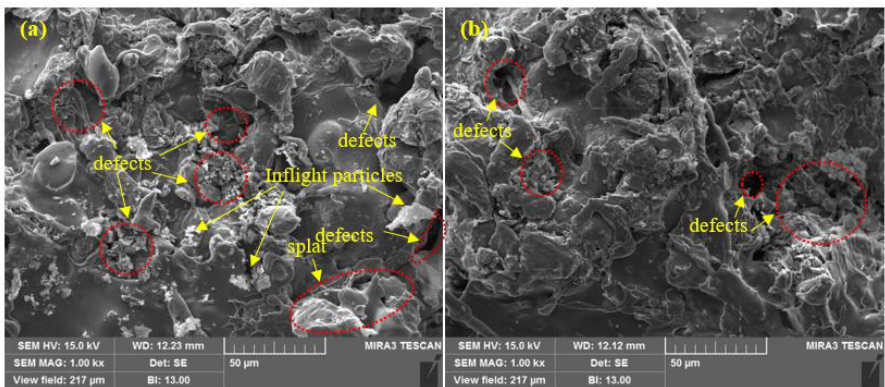
Figure 2. SEM images of the zinc coating deposited by the ( a ) arc thermal spray and ( b ) plasma arc thermal spray processes at 1000×.